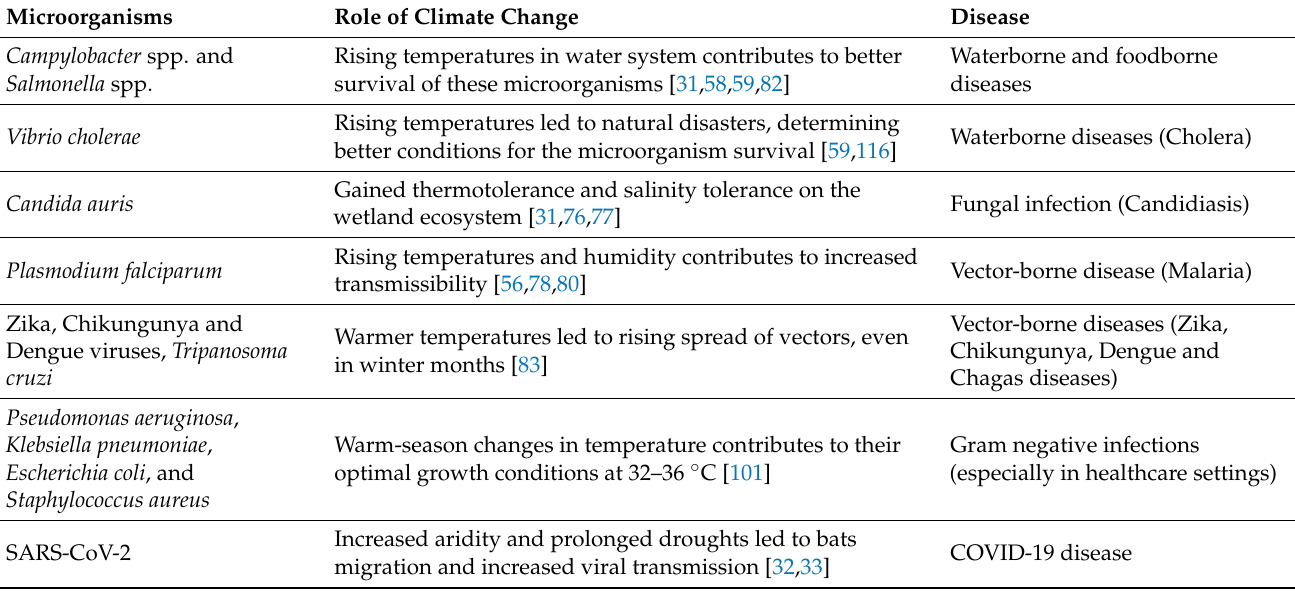
Table 1. Summary of the relationship between climate change and